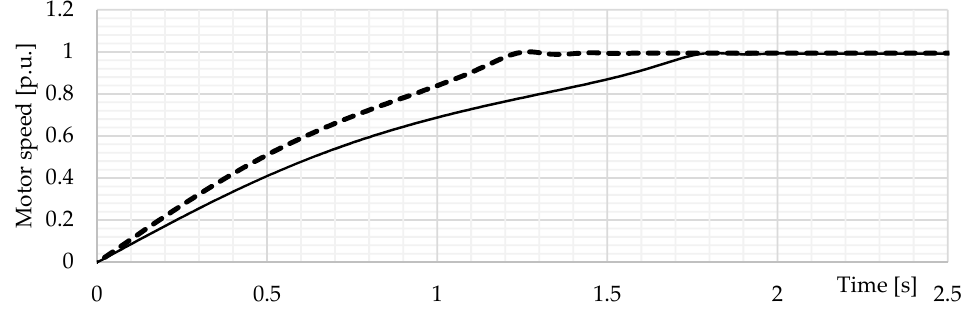
Figure 11. 110 kW asynchronous motor starting speed with SVC implemented (dashed line) and without SVC implemented (solid line).